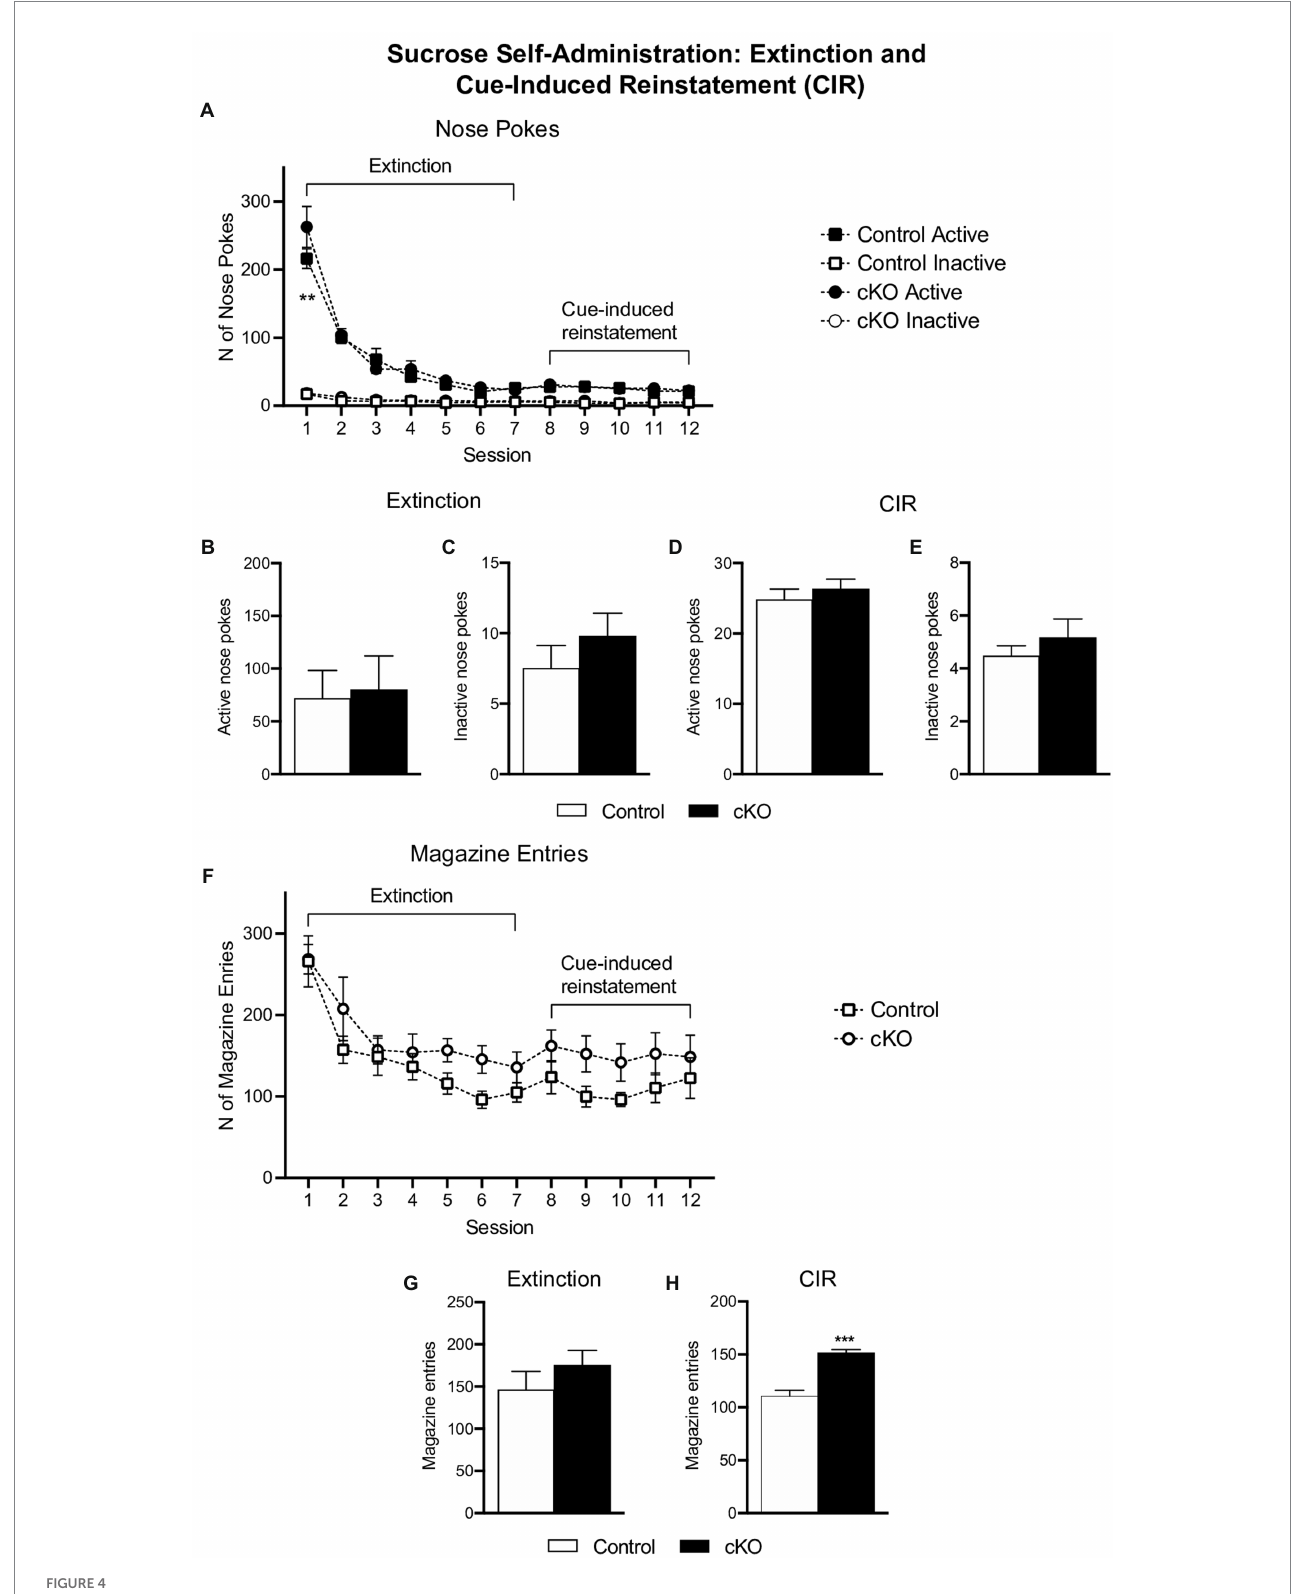
FIGURE 4 Active (filled symbols) and inactive (clear symbols) nose pokes of control (squares) and cKO (circles) mice throughout the extinction and cue-induced reinstatement (CIR) phases (A) . Average of active (B,D) and inactive (C,E) nose pokes of control (white bars) and cKO (black bars) mice in extinction and CIR phases. Magazine entries throughout the extinction and CIR phases (F) and average of responses separate for each phase (G,H) . Data are expressed as mean ± SEM. ** p = 0.0011, Tukey’s post-hoc comparison test vs. control mice; *** p < 0.001 vs. control mice unpaired t